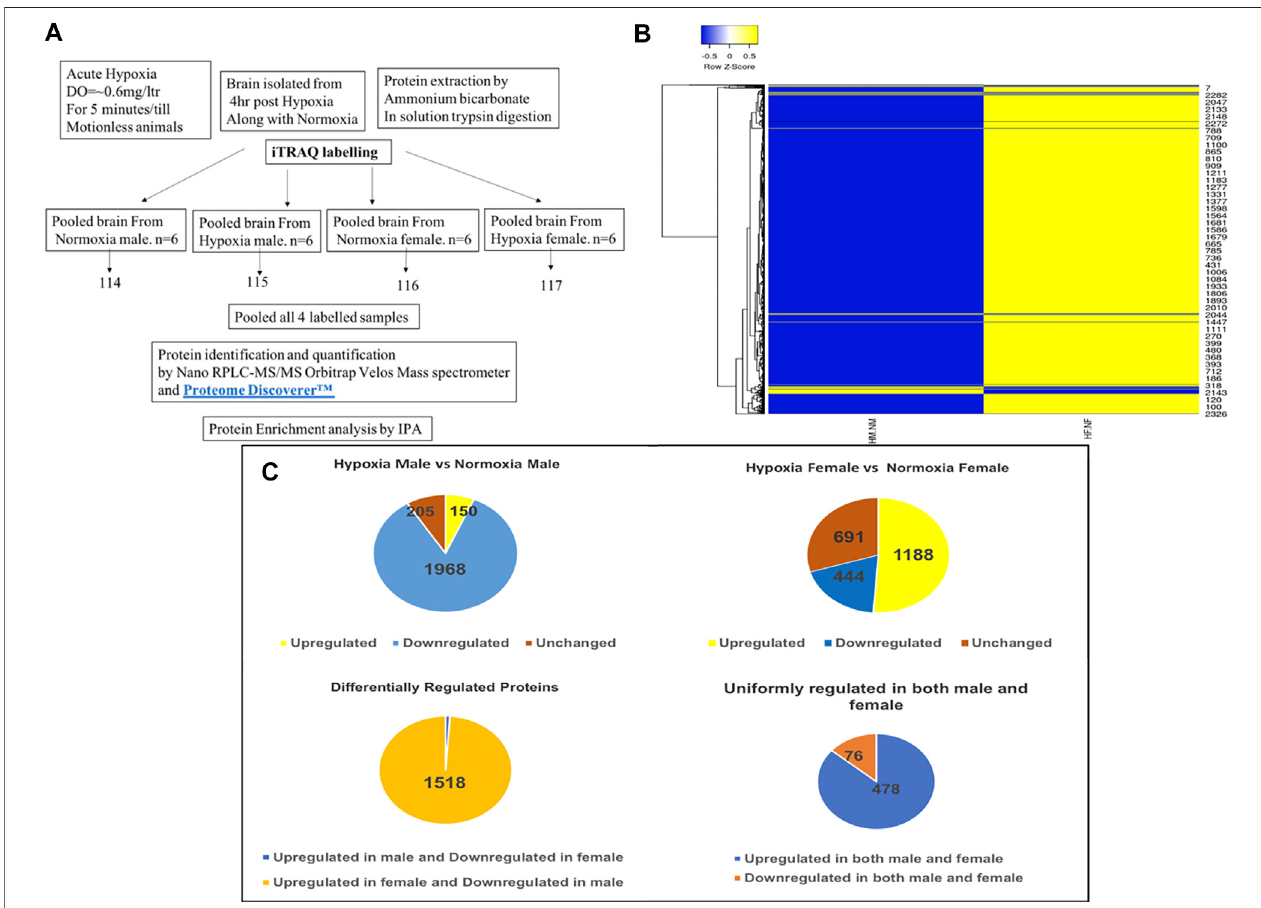
FIGURE 1 | Analysis of zebra fi sh brain proteome by iTRAQ. Schematic representation of brain proteome analysis by iTRAQ labeling (A) , Cluster heatmap of proteins obtained from iTRAQ analysis for hypoxia male [HM] vs. normoxia male [NM] and hypoxia female [HF] vs. normoxia female [NF] (B) , Pie chart showing the analysis of expression of proteins resulted from iTRAQ in hypoxia male and female brain compared with normoxia male and female brain (C) .